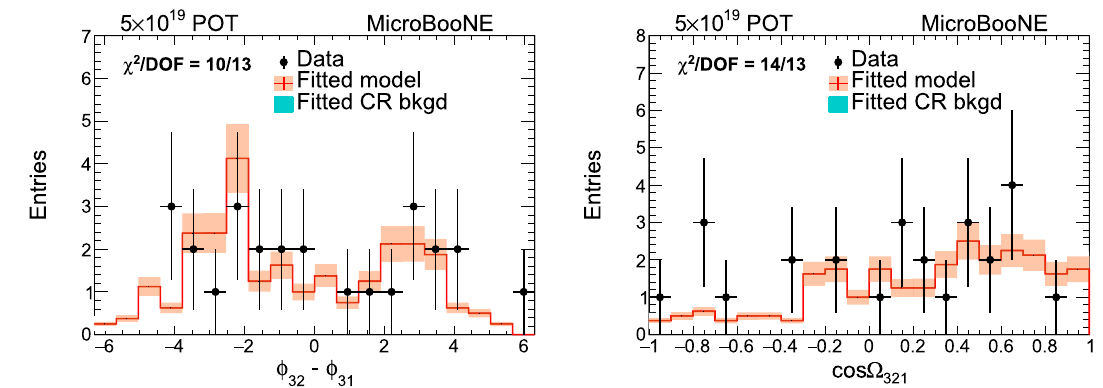
Fig. 25 Multiplicity = 3 φ 2 − φ 1 distribution (left); cos (cid:18) 21 distribution between first and second track (right) from neutrino-enriched sample for data and GENIE default